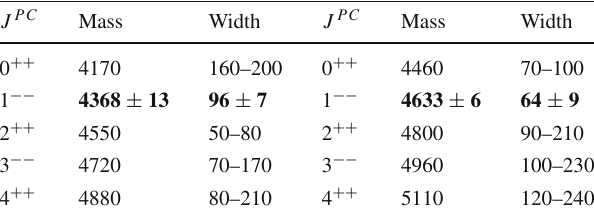
Table 1 States on the radial trajectory of the (cid:3)( 4360 ) / (cid:3)( 4660 ) . The higher excited states are expected to decay into (cid:4) c (cid:4) c . Another possible lower state, which is expected to be wider than